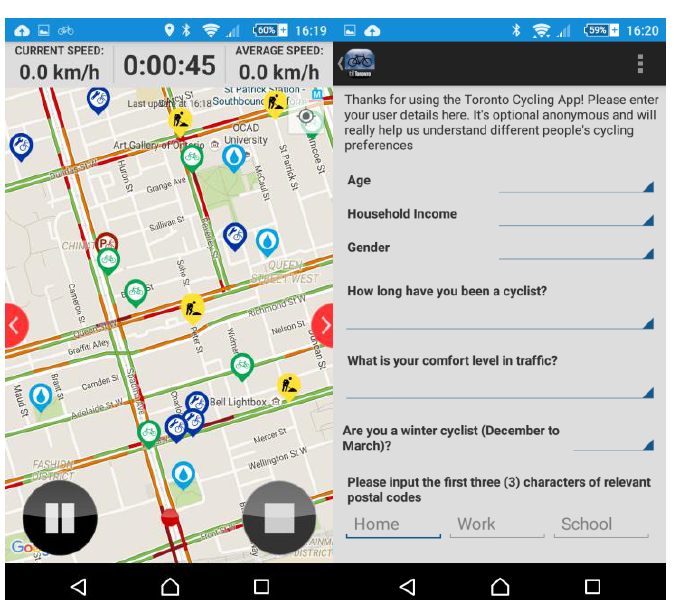
Figure 1. Citizen budget interface.